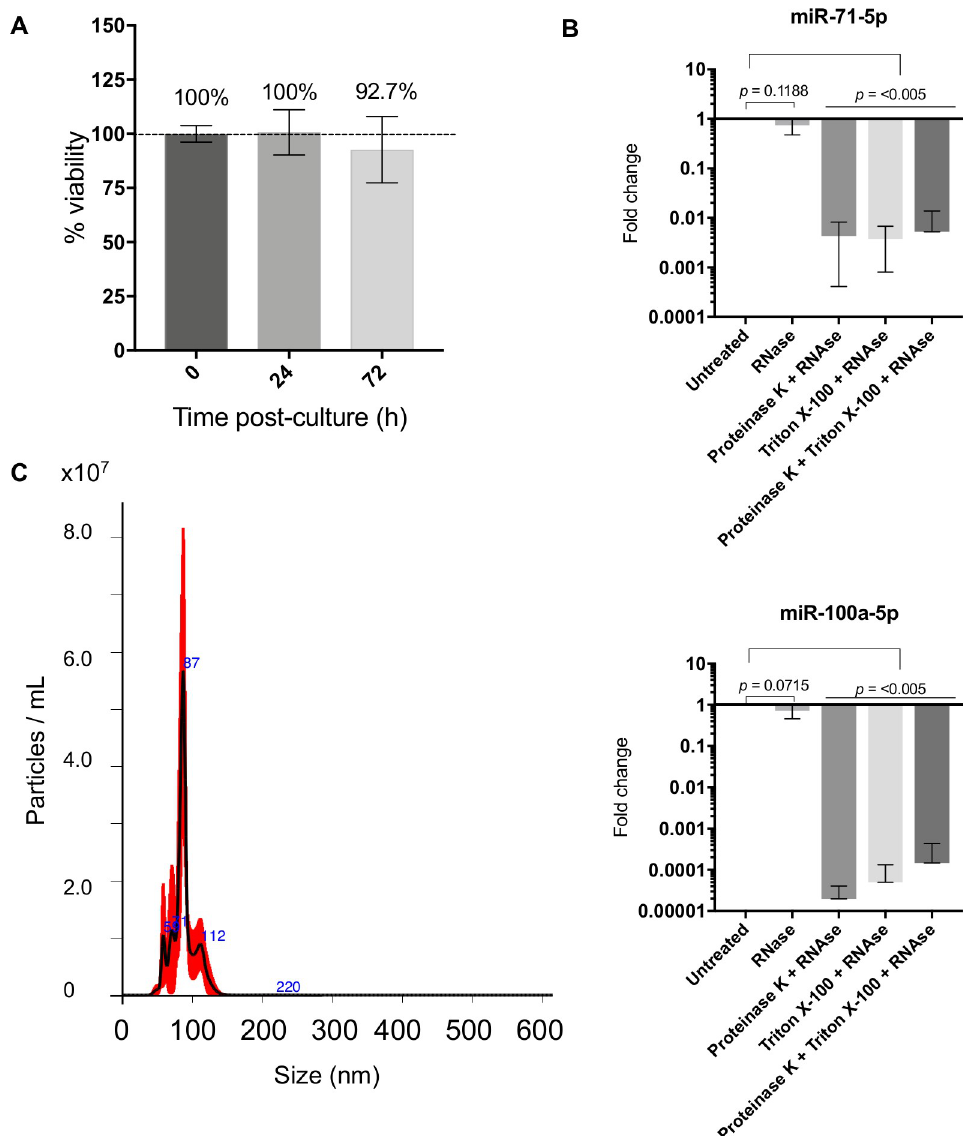
Fig 4. Viable gravid adult females secrete EVs and small RNAs that are protected from degradation. A) Viability of gAF worms over time in vitro ( n = 2 independent experiments) reported as average ± standard deviation. B) RNase sensitivity of RNAs of miR-71-5p and miR-100a-5p (detected in the ES from gAFs) in the absence and presence of proteinase K (5 μ g/uL) and Triton X (0.05%) for 30 min at 37˚C. Results are reported as average ± standard deviation (n = 4). P values were calculated using either Student’s unpaired t test or Kolmogorov-Smirnov test using the “untreated” experimental group as a reference; p < 0.05 was considered statistically significant. C) Size measurement of the extracellular vesicles detected in the ES from gAFs using NanoSight particle tracking (NTA) system. could also be the host let-7 species with a non-templated addition of “A”); these are denoted in Fig 6A, bottom panel). By comparing infected samples to na ï ve (which is not possible with ES products) we also note that some L . sigmondontis sRNAs are identified in na ï ve serum samples (rRNA and exon-derived RNAs and some miRNAs). These may represent sequences that map to L . sigmodontis but are also similar to the host or to other potential in vitro contaminants (bacteria, fungi). To have confidence that the L . sigmondontis miRNA reads detected in serum